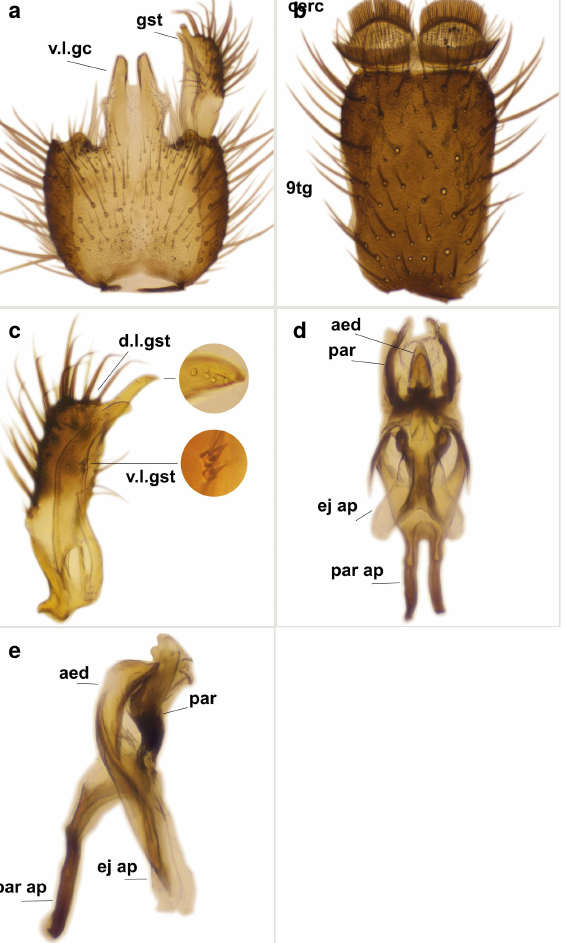
Figure 7. Boletina curta Sasakawa & Kimura, paratype male, hypopygium. a : Hypopygium, ventral view. gst=gonostylus, v.l.gc=ventral lobes of